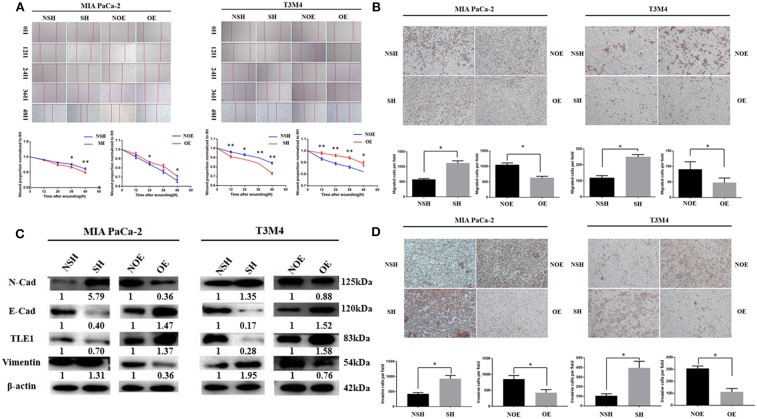
TLE1 inhibits PDAC cell migration and invasion in vitro. (A) PDAC cell migration capabilities were evaluated by wound healing assays in MIA PaCa-2 and T3M4 cells (magnification: 100×). (B) PDAC cell migration abilities were assessed by transwell assays in MIA PaCa-2 and T3M4 cells (magnification: 100×). (C) PDAC cell invasion abilities were assessed by transwell assays in MIA PaCa-2 and T3M4 cells (magnification: 100×). (D) TLE1 overexpression increased E-cadherin expression and decreased N-cadherin and vimentin expression, whereas TLE1 knockdown had the opposite effects. Data are presented as mean ± SD. *P < 0.05, **P < 0.01, by Student's t-test. TLE1, transducin-like enhancer of split-1; PDAC, pancreatic ductal adenocarcinoma; OE, TLE1 overexpression; NOE, negative control for TLE1 overexpression; SH, TLE1 knockdown; NSH, scrambled control (n = 3).